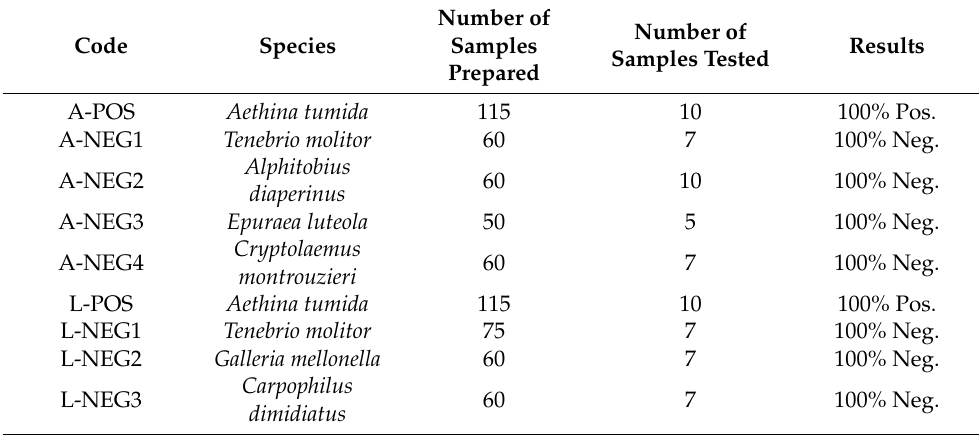
Table A1. Sampling strategy for homogeneity tests and results.